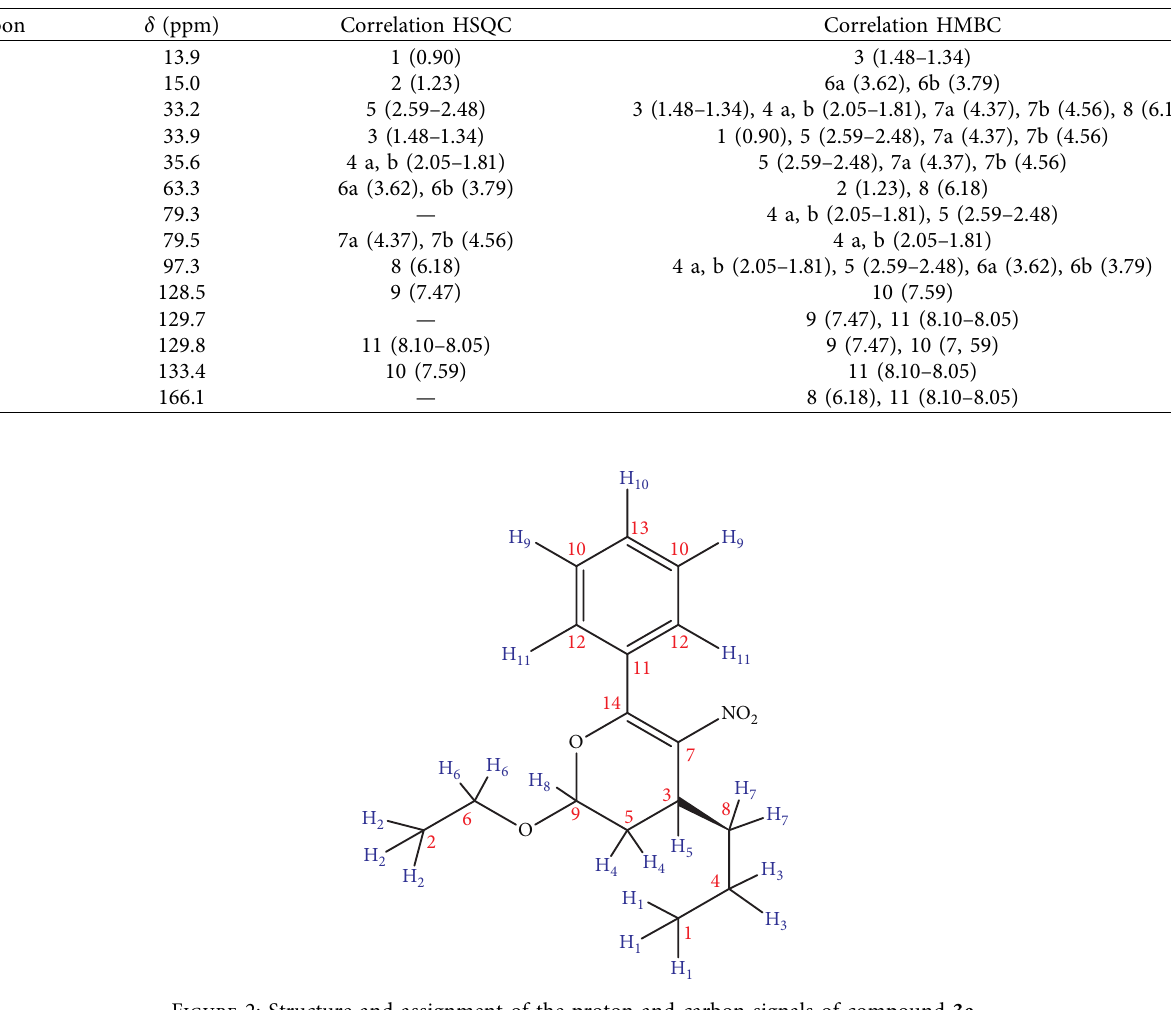
Table 3: Correlations for 3c in the HSQC and HMBC